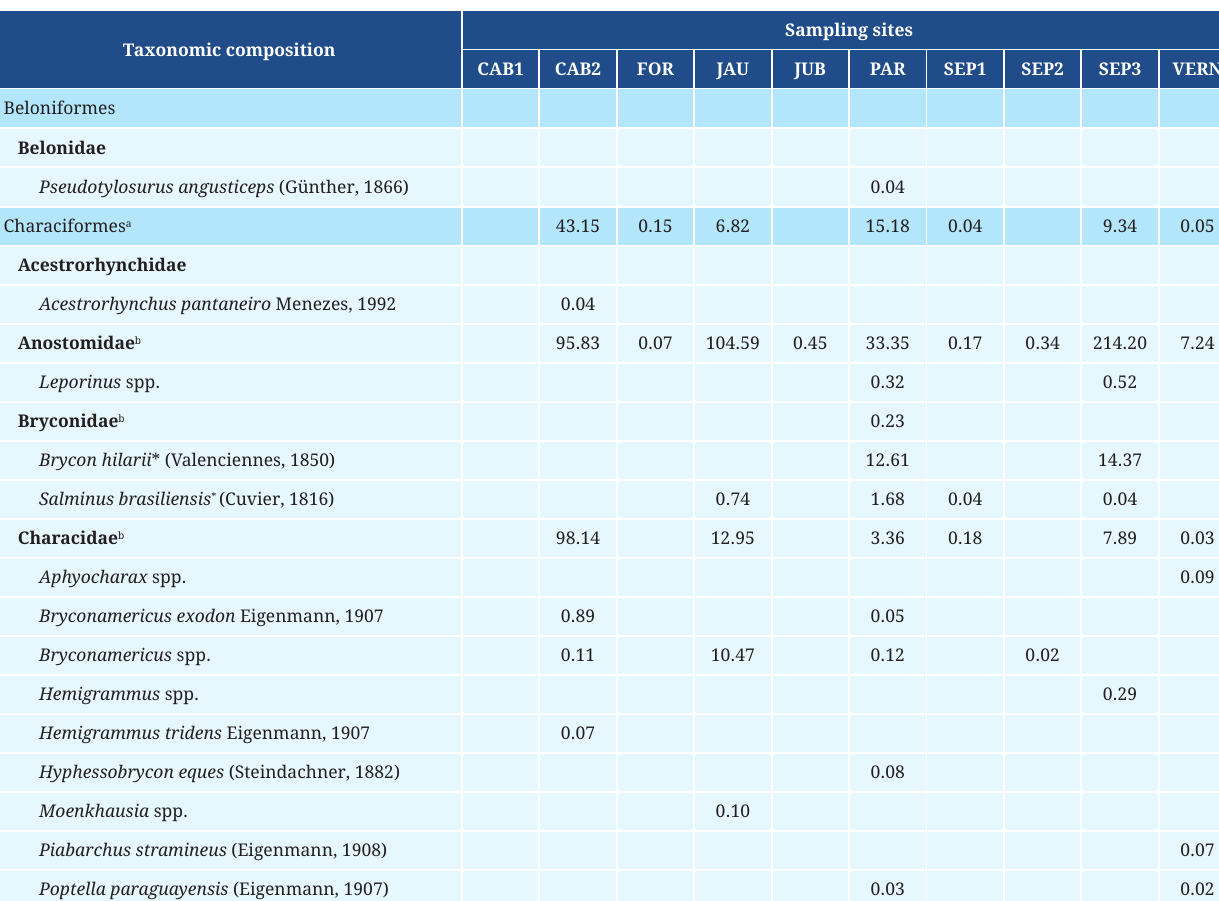
Taxonomic composition. The individuals recorded in this study belonged to five taxonomic orders and 25 families, with the highest densities being recorded for the orders Characiformes, Siluriformes. Anostomidae, Characidae, and Pimelodidae were the families with the highest larval densities. The larvae were distributed in 55 lower taxa (Tab. 1), including individuals representing the commercially valuable migratory species Brycon hilarii (Valenciennes, 1850), Hemisorubim platyrhynchos (Valenciennes, 1840), Piaractus mesopotamicus (Holmberg, 1887), Prochilodus lineatus (Valenciennes, 1837), Pseudoplatystoma spp., Salminus brasiliensis (Cuvier, 1816), Sorubim lima (Bloch, Schneider, 1801), and Zungaro jahu (Ihering, 1898). The highest larval densities were recorded for P . lineatus , Rhaphiodon vulpinus Spix & Agassiz, 1829, and H . platyrhynchos , whereas the larvae of Z . jahu were collected only on the Sepotuba River (SEP1, SEP2, and SEP3). TABLE 1 | Mean density (per 10 m 3 ) of the fish larvae taxa sampled in the upper Paraguay River basin in the Brazilian state of Mato Grosso during the breeding seasons of 2017/2018 and 2018/2019. CAB1 = Cabaçal River site 1; CAB2 = Cabaçal River site 2; FOR = Formoso River; JAU = Jauru River; JUB = Juba River; PAR = Paraguay River; SEP1 = Sepotuba River site 1; SEP2 = Sepotuba River site 2; SEP3 = Sepotuba River site 3; VERN = Vermelho River; a Larvae identified to order; b Larvae identified to family; c Larvae identified to subfamily; *Commercially valuable migratory